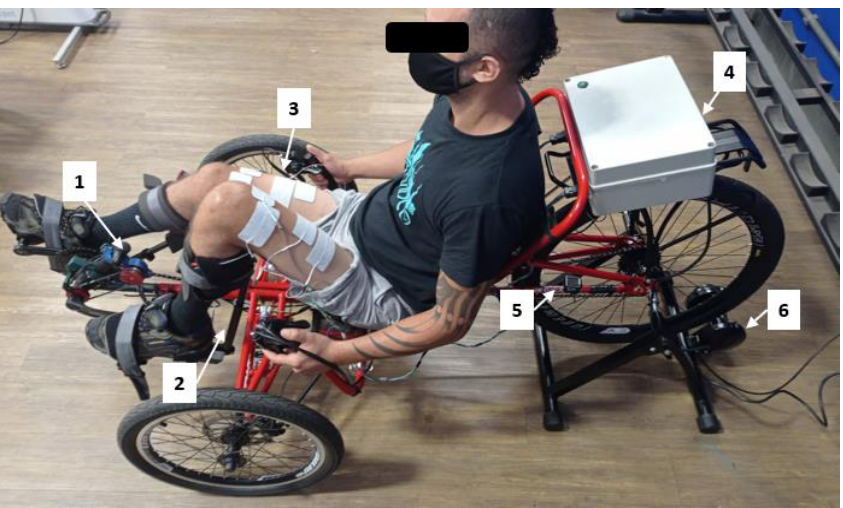
Figure 6. Tadpole tricycle and main components: ( 1 ) rotary Encoder, ( 2 ) calf support, ( 3 ) surface electrodes, ( 4 ) proprietary stimulator, ( 5 ) speed sensor, ( 6 ) cycling trainer.